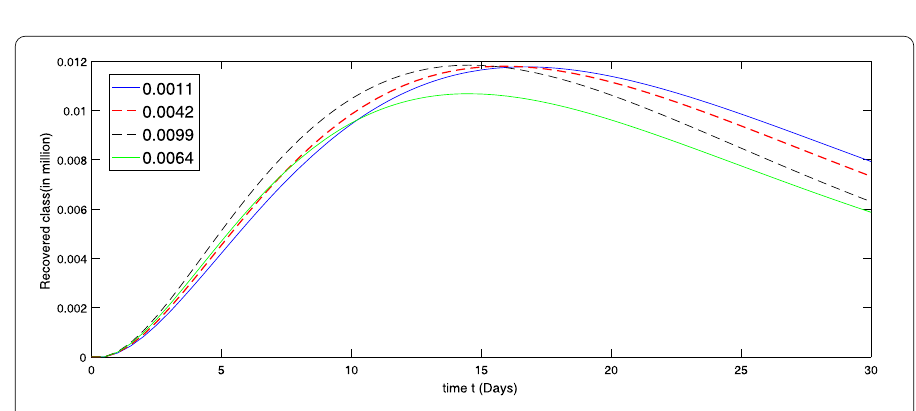
Figure 7 Dynamical behavior of the recovered class in the presence of given rate of emigrant(s) as Case II from 10 March to 10 April